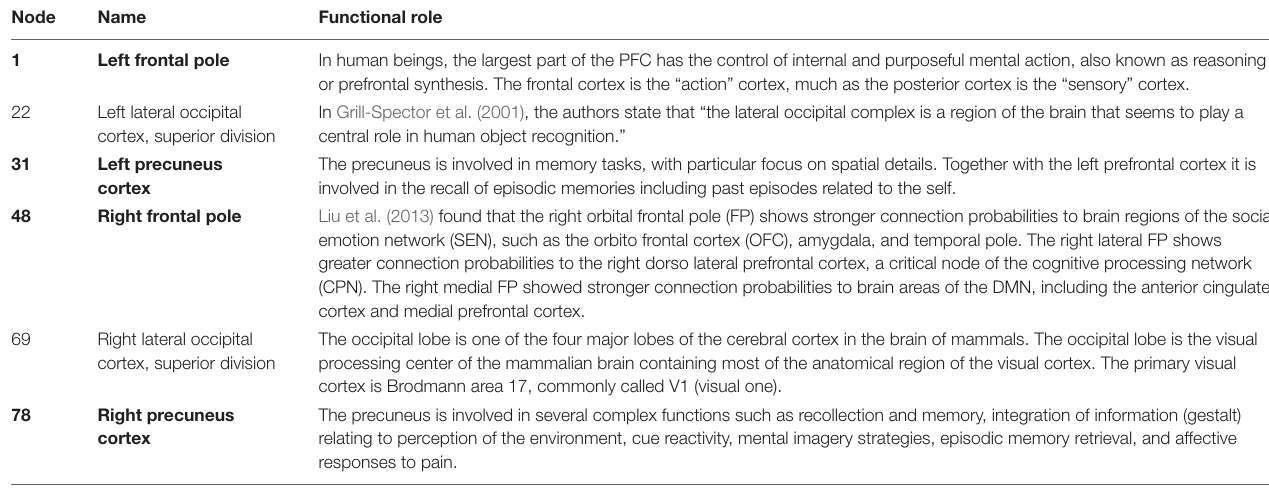
TABLE 2 | Neurobiological relevant nodes emerging from the topological graphlet-based algorithm of section “Frequency Table and Node